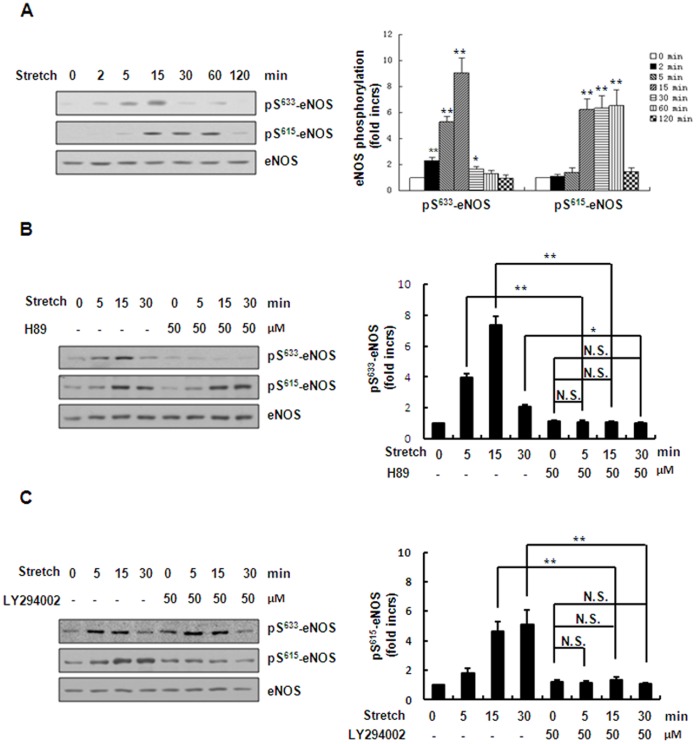
PKA and PI3K/Akt pathways respectively mediate stretch-induced eNOS-Ser633 and Ser615 phosphorylation.(A) Left: Western blots of Ser633 and Ser615 phosphorylation of eNOS in HUVECs under continuous stretch (50%) for the times indicated. Right: quantitative analysis of Ser633and Ser615phosphorylation of eNOS. (B) Left: Western blots of Ser633 and Ser615 phosphorylation of eNOS in HUVECs under continuous stretch (50%) for the times indicated, pretreated with or without 50 µM H89. Right: quantitative analysis of Ser633 and Ser615 phosphorylation of eNOS. (C) Left: Western blots of Ser633 and Ser615 phosphorylation of eNOS in HUVECs under continuous stretch (50%) for the times indicated, pretreated with or without 50 µMLY294002. Right: quantitative analysis of Ser633 and Ser615 phosphorylation of eNOS. Results are representative of 3 individual experiments and expressed as mean ± S.D. (n = 4). *p<0.05; **p<0.01; N.S., not significant.